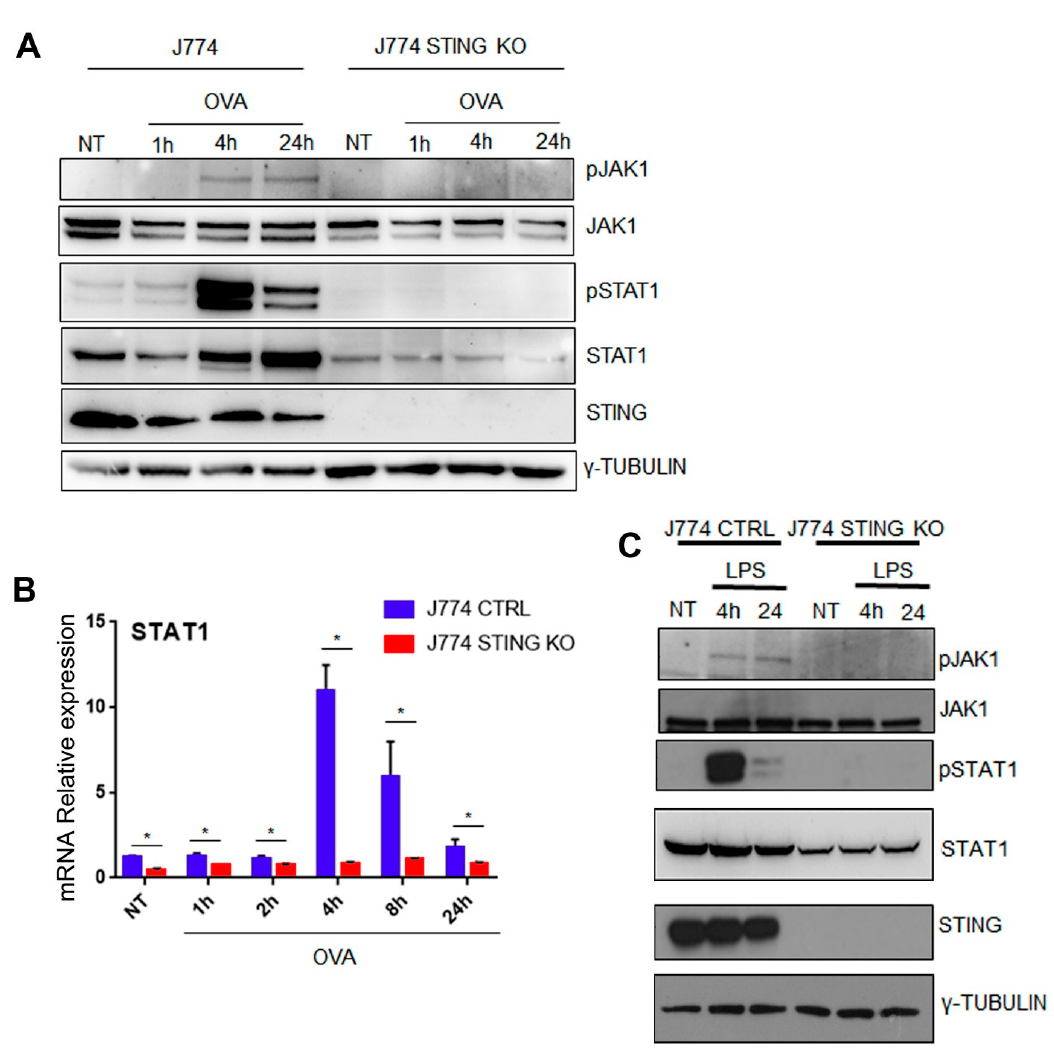
experiments. The asterisks indicate statistically significant differences between CTRL and KO cells, according to a Student’s t test ( p < 0.01). ( E ) J774 CTRL and STING KO cells (5 × 10 6 ) were treated with 500 µ g/mL of OVA or left untreated for the indicated time. Whole cell extracts (30 µ g) were analyzed by western blot using the indicated antibodies. γ -Tubulin was included as control for protein loading. ( F ) Quantifications of the protein levels of β 2 m in CTRL (blue bars) and STING KO (red bars) cells were calculated by ImageJ software as fold-change relative to unstimulated, which was set to 1.0. Values (mean ± SE, n = 4) are shown.